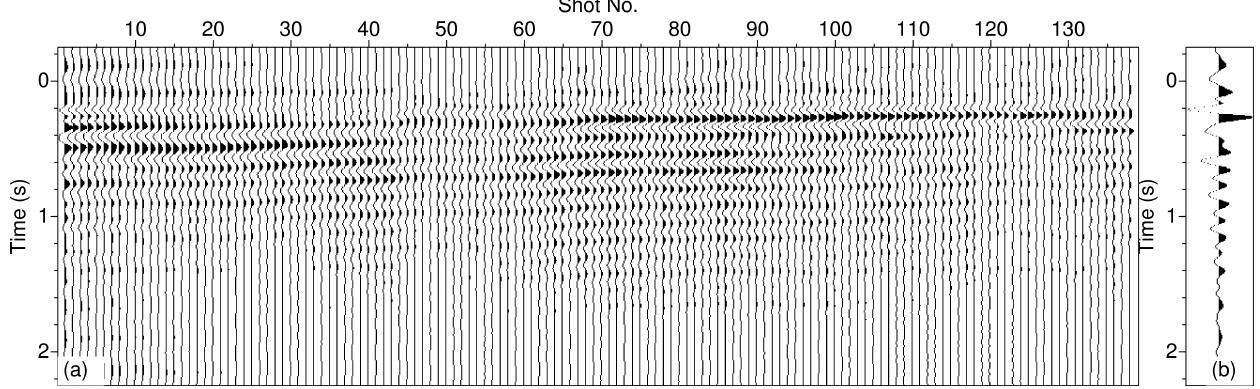
Figure 9. ( a ) Source signature obtained using the final travel time inversion velocity model and ( b ) average source signature over all